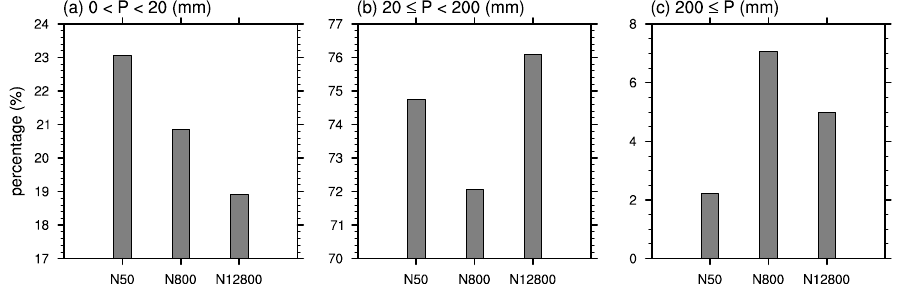
Figure 7. Spatial proportions of ( a ) weak (0 mm < P < 20 mm), ( b ) moderate (20 mm ≤ P < 200 mm), and ( c ) heavy precipitation (200 mm ≤ P ) in terms of the percent area of the analysis domain covered by precipitation in the N 0 = 50, 800, and 12,800 cm − 3 cases. P (in mm) is the accumulated surface precipitation amount at each of the surface grid points.